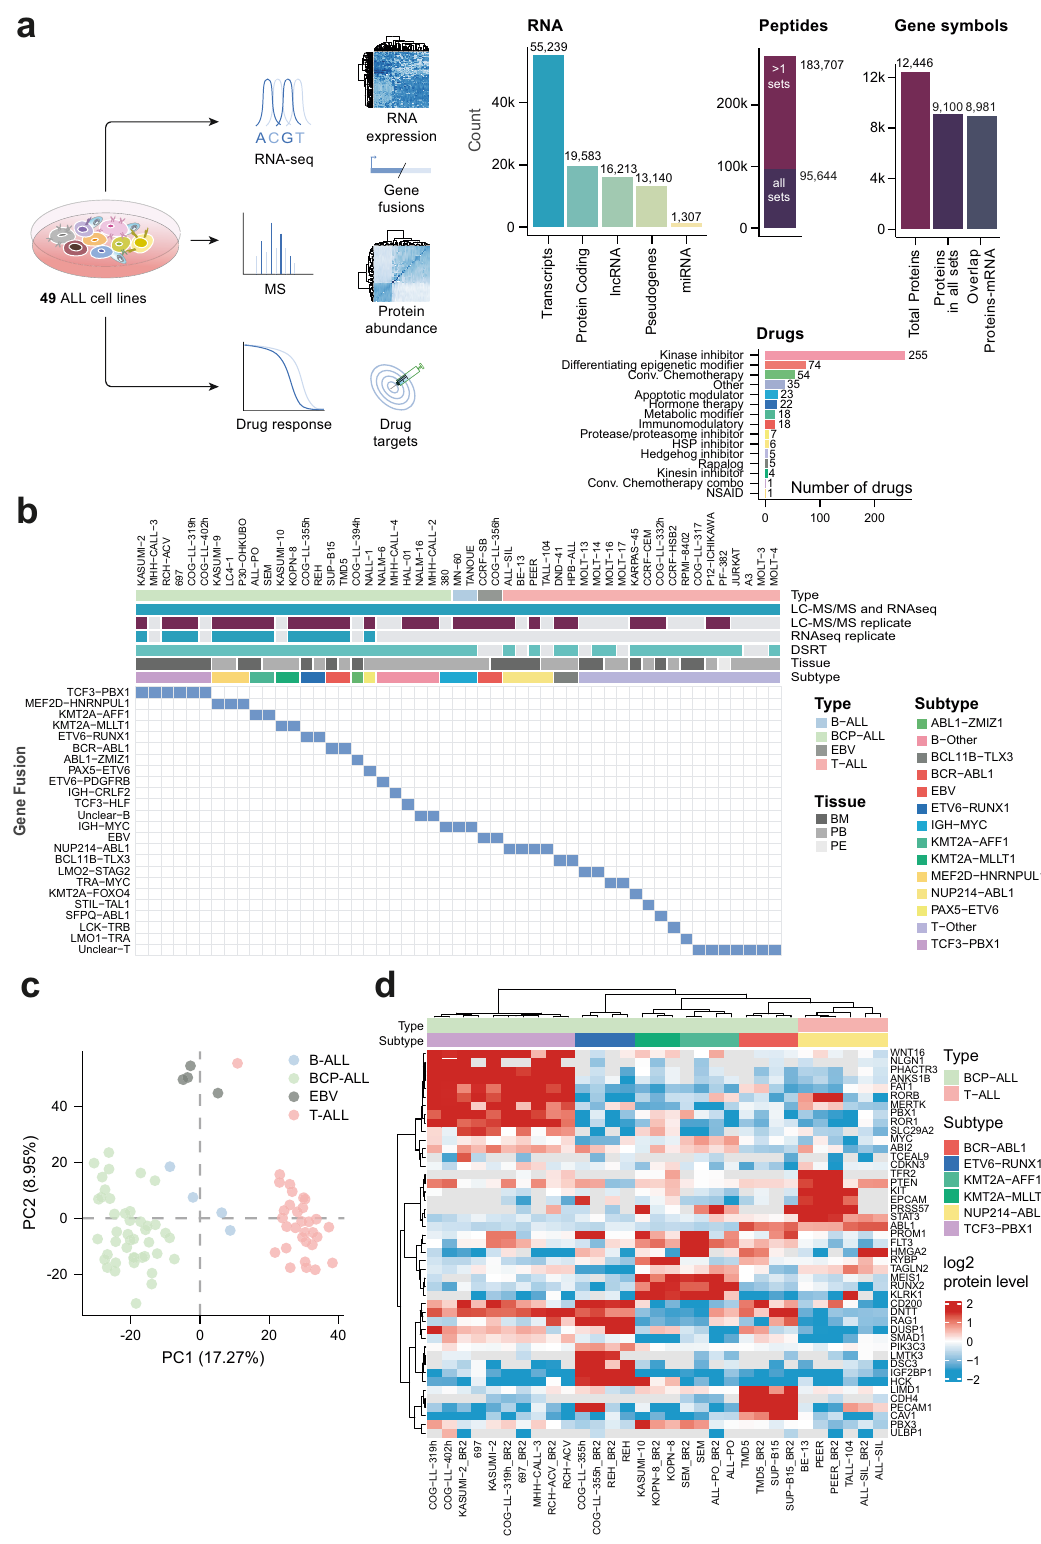
Fig. 1 Multi-omics pro fi ling of childhood ALL cell lines. a Schematic work fl ow of childhood ALL cell lines data generation and analyses conducted in this study. Cells were pro fi led for protein level using mass spectrometry and mRNA expression using RNA-seq. The majority of the cell lines, excluding derivative or sister cell lines ( n = 43) were scanned for their sensitivity to 528 investigational and oncology drugs. b An overview of the most prominent molecular features of the 51 cell lines in this panel. BM bone marrow, PB peripheral blood, PE peripheral effusion, DSRT drug sensitivity and resistance testing. c Principal component analysis (PCA) of the highly variable proteins in the 51 cell lines showed distinct clusters corresponding to BCP-ALL (green), immature B-ALL (blue), T-ALL (pink), and EBV-transformed B cells (gray). d Cell lines grouped by the most prominent features of the described cytogenetic subtypes using proteomics data. BR biological replicate. Source data are provided as a Source Data File 1. NATURE COMMUNICATIONS| (2022) 13:1691